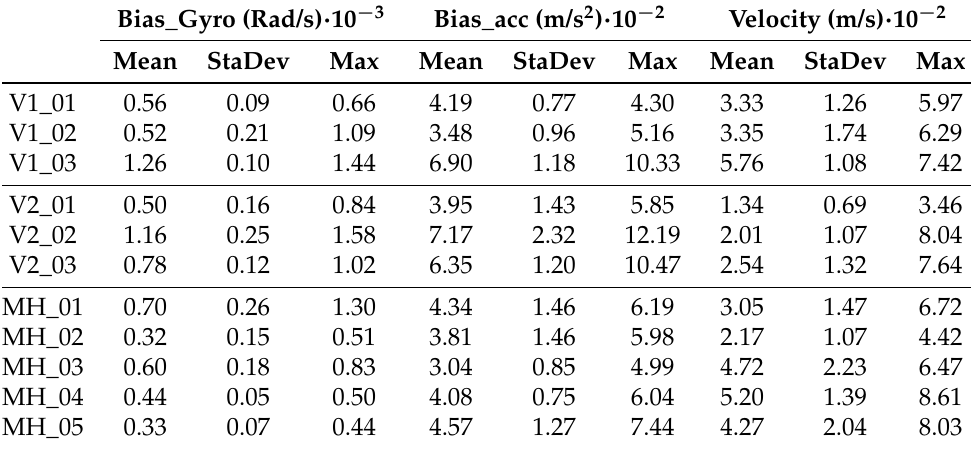
Table 4. Errors of the Estimated Initial Values on the EuRoC Dataset 1 .